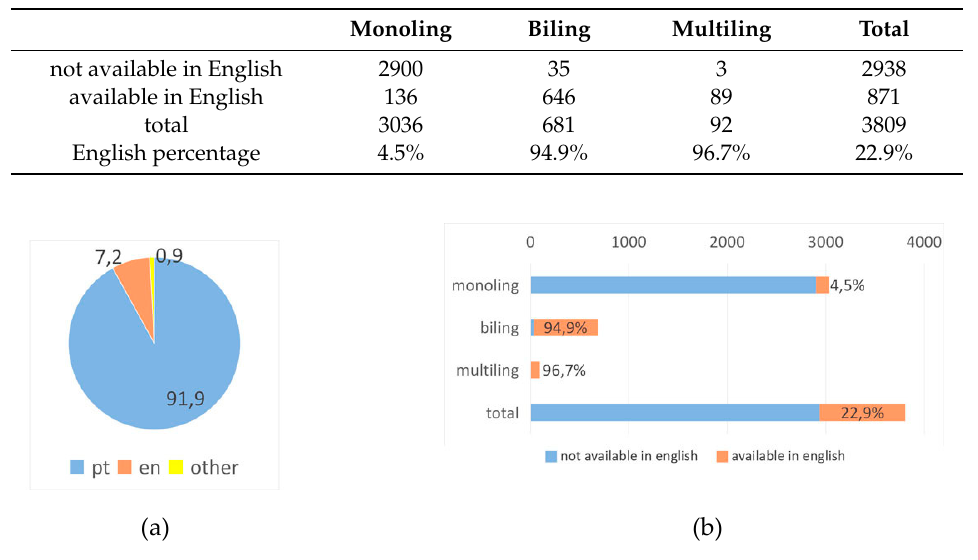
Table A45. Primary languages (ro).